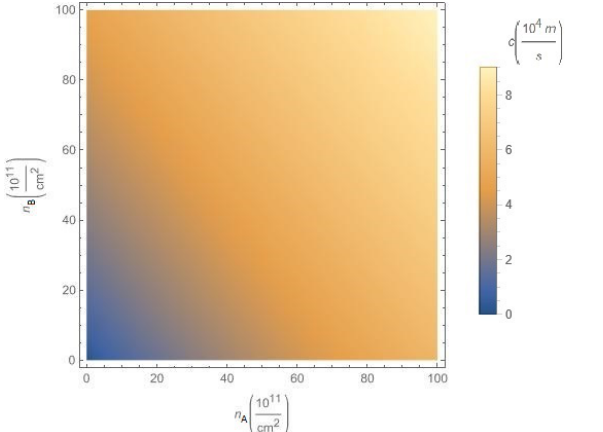
Figure 10. The sound velocity c ≡ c 1 versus the concentrations n A and n B of A and B excitons, respectively, for chosen parameter α = 0.6 and gap ∆ = 0.5 ¯ hv F / a , at the fixed interlayer separation D = 25